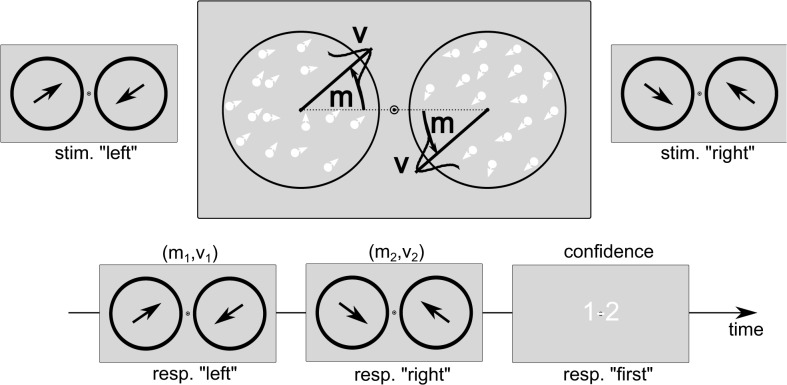
Experimental paradigm.Top: schematic representation of the stimulus and response categories. Bottom: timeline representation of a pair of first order trial, followed by a confidence comparison judgment.